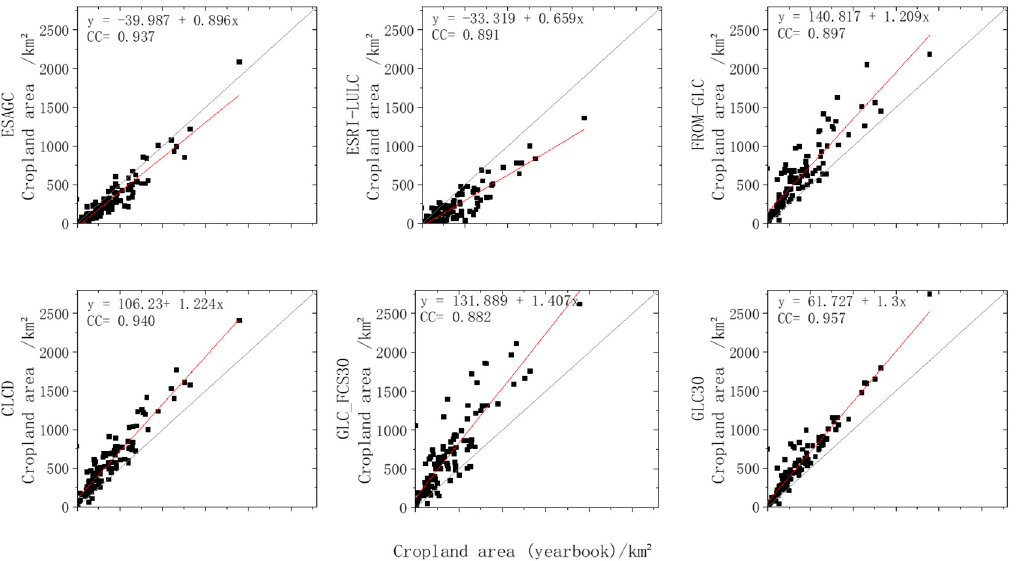
Figure 8. Scatter plots showing a comparison of the cropland area at the county level in Guangxi between the six land cover data sets and the statistical yearbook data.